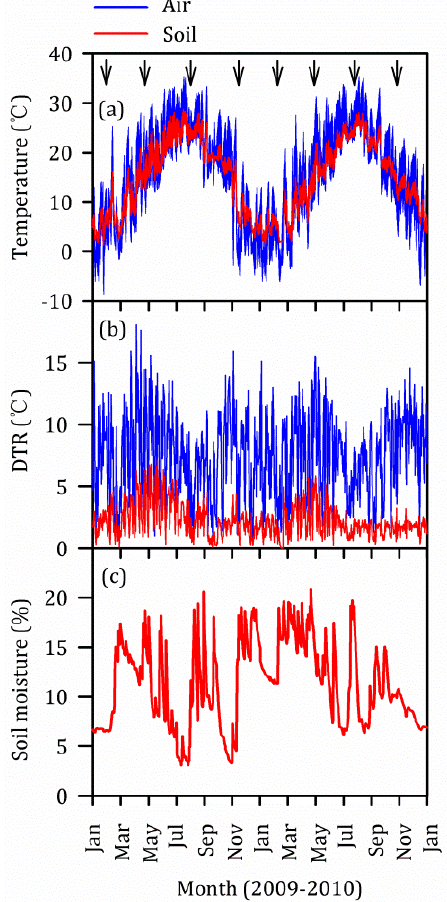
Figure 5. Daily maximum temperature, daily minimum temperature in air (blue) and soil (red) ( a ), diurnal temperature range (DTR) in air (DTR air ) and soil (DTR soil ) ( b ), and soil moisture ( c ) over a 2 year period in subtropical forest ecosystem of central China. DTR is the difference between maximum and minimum temperature within one calendar day. The arrows mark the timing of field campaigns when the measurements of respiration were initiated.